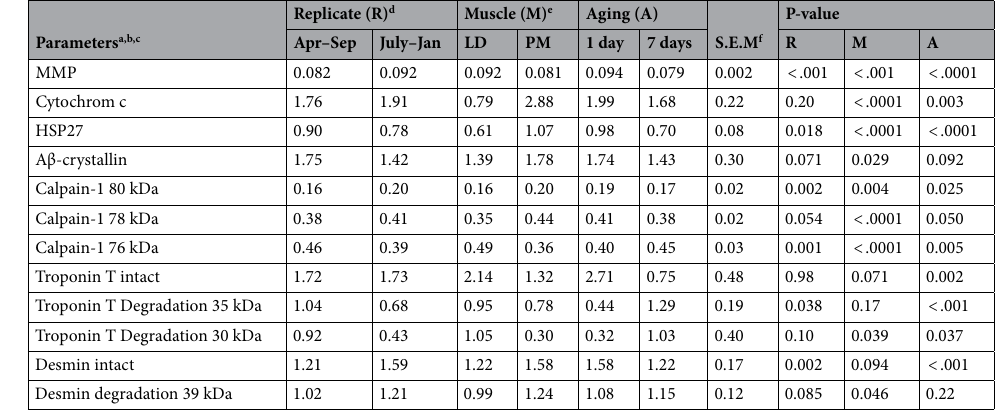
Table 1. Effect of different production replicates and muscle types on proteolysis and apoptosis features of porcine skeletal muscles over 7-day postmortem aging. a MMP (mitochondrial membrane permeability) was obtained by measuring UV absorption peak at 540 nm of the isolated mitochondria suspensions, higher number indicates lower MMP. b Protein abundance except calpain-1 was expressed as relative ratio of band intensity compared to the corresponding bands of the reference samples. c Three bands of 80, 78, and 76 kDa of calpain-1 were quantified and expressed as the ratio of each band that relative to the total intensity. d Replicate: July–Jan, pigs weaned in July 2016 and harvested in January 2017; Apr–Sep: pigs weaned in April 2017 and harvested in September 2017. e Muscle: LD, longissimus dorsi; PM, psoas major. f Pooled standard errors of means.